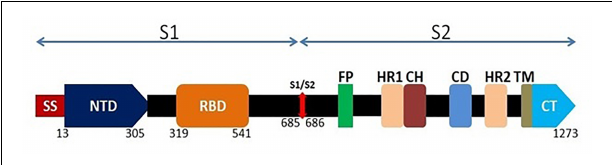
FIGURE 1 | Schematic genomic organization of the full length spike glycoprotein of SARS-CoV-2. The surface spike protein contains S1 and S2 domain. At the N terminal, S1 domain consists of a signal sequence (SS) which is followed by N-terminal domain (NTD; 293 amino acids) and Receptor Binding Domain (RBD; 222 amino acids). S2 domain consists of fusion peptide (FP) followed by two heptad repeats (HR1 and HR2), a central helix (CH), a connector domain (CD), a transmembrane domain (TM) and the cytoplasmic tail